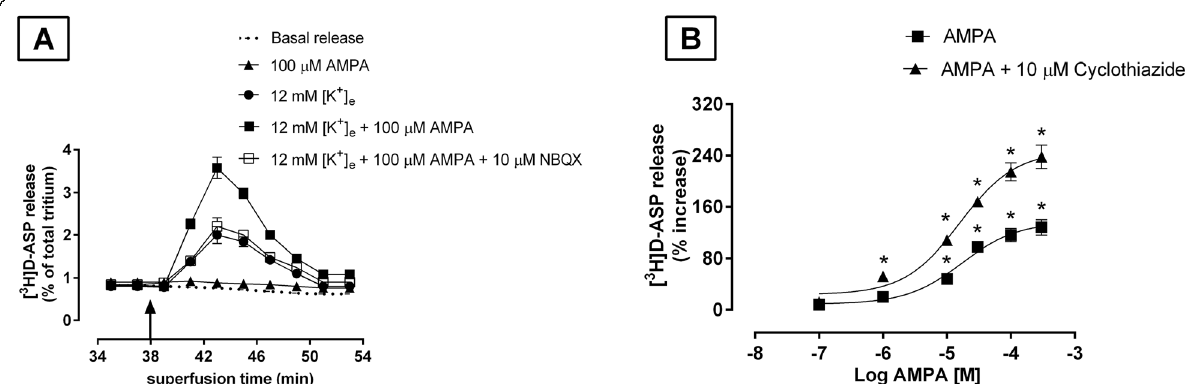
Fig. 2 Effects of AMPA on basal and 12 mM [K + ] e -evoked [ 3 H]D-ASP release from rat TCN synaptosomes. a Effects of AMPA and antagonism by NBQX. Synaptosomes were prepared as previously described, and perfused for 37 min with standard medium. From min 38 through min 41, perfusion was carried out with standard medium containing 100 μ M AMPA or depolarizing medium plus 100 μ M AMPA. When used, the antagonist NBQX (10 μ M) was added to the medium 8 min before AMPA. Each point represents the mean ± S.E.M. of 3 – 4 different experiments, each run in triplicate. b Cyclothiazide-sensitivity. The AMPA receptor desensitization inhibitor cyclothiazide (CTZ) (10 μ M) was added concomitantly with AMPA (0.1 – 300 μ M) to the depolarizing medium. The effects of the drugs on evoked release are expressed as percentage increases over values observed in the presence of the depolarizing stimulus alone. Data are means ± SEM of 3 experiments, each run in triplicate. *P < 0.05 vs [K + ]